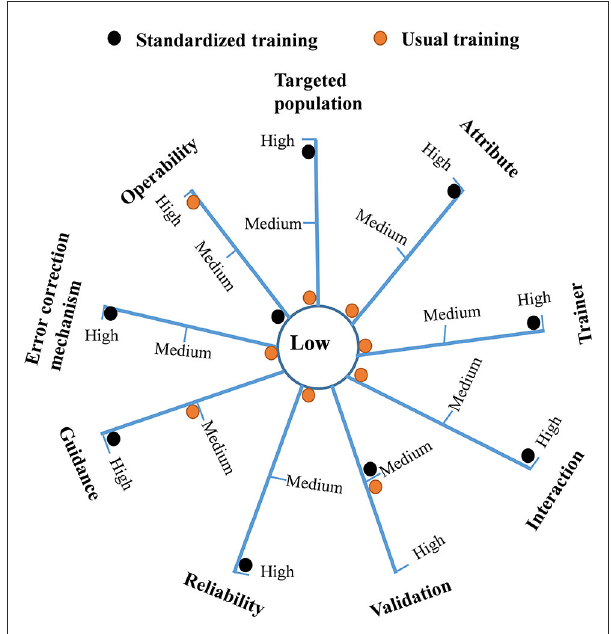
FIGURE2 A radar diagram reflecting the distribution of the usual training model and standardized training model at different levels for each qualitative indicator. The total score of the standardized training model and usual training model were 24 and 13, respectively.